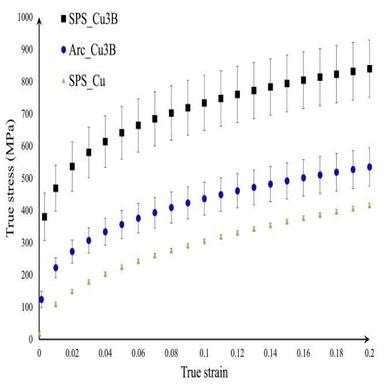
Calculated true stress-strain profiles of the SPS_Cu, Arc_Cu3B, and SPS_Cu3B samples. The error bars indicated scattering in the indentation data.